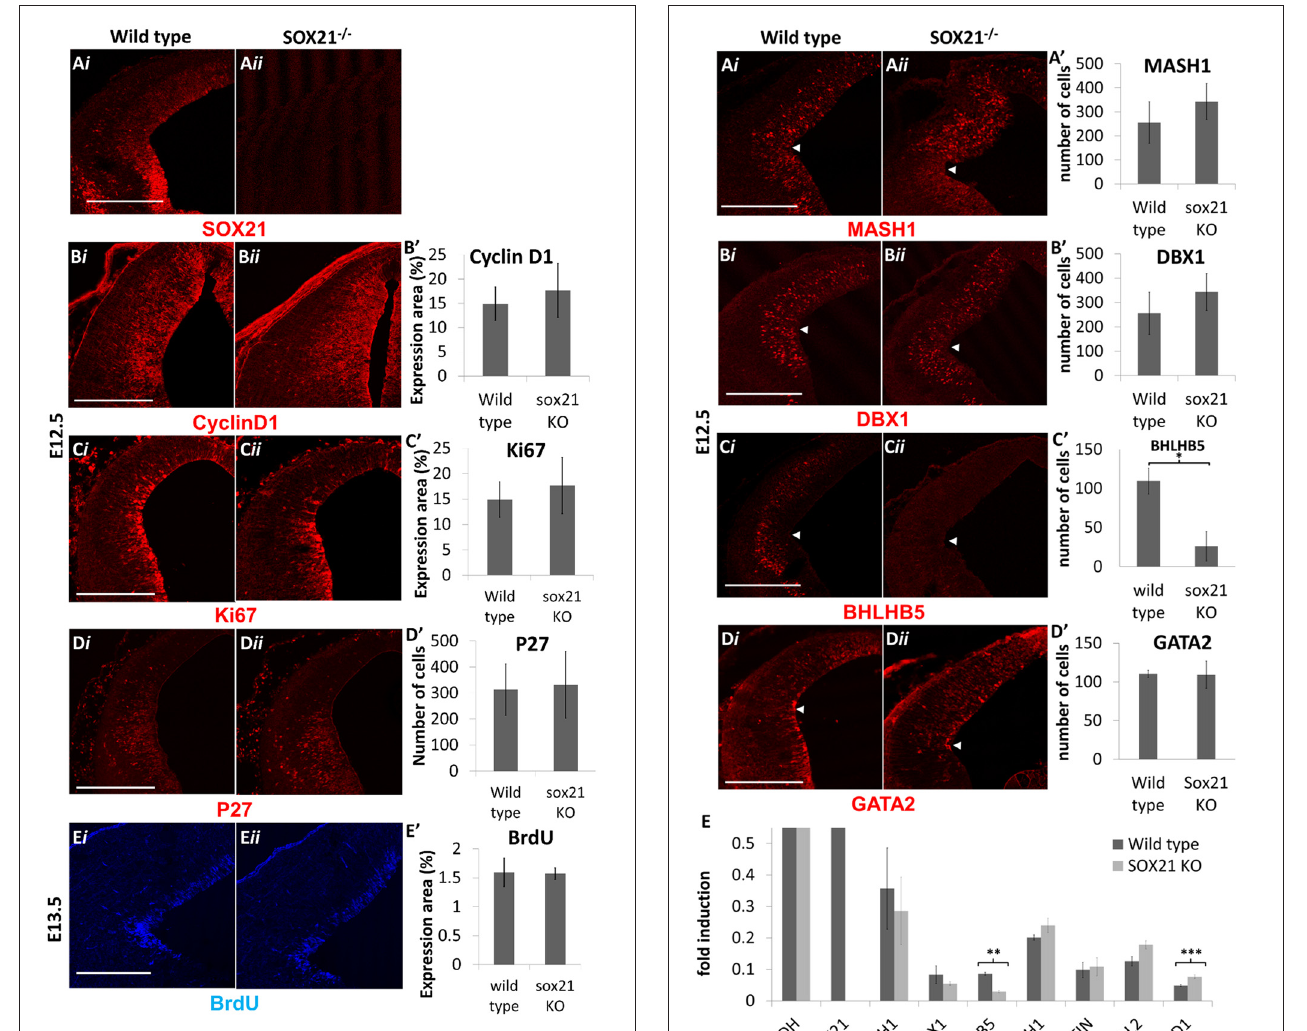
FIGURE 3 | Analysis of cell proliferation in SOX21 − / − embryos. The absence of SOX21 in the knockout embryos was validated by antibody staining (A) . The area of expression of the cell cycle markers CyclinD1 (B,B (cid:48) ) , Ki67 (C,C (cid:48) ) and BrdU (E,E (cid:48) ) by antibody staining was similar between knockout ( ii ) and wild type embryos ( i ) as well as no differences between the numbers of cell cycle arrest p27 + ve cells were observed (D,D (cid:48) ) . Data are represented as mean ± SEM, n = 10 (5 pairs of mice). Scale bar, 150 µ m.